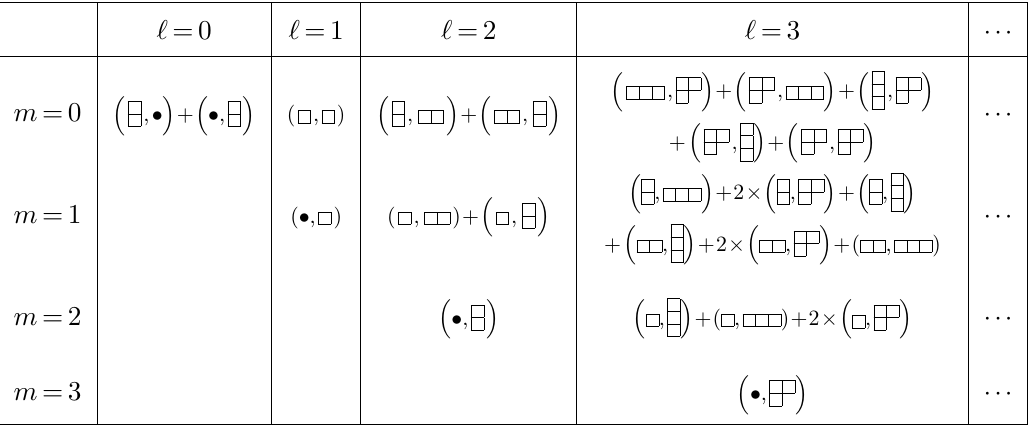
Table 5 . The free Lie algebra for the ‘magnetic’ string Galilei algebra. As objects now transform under SO( D (cid:0) p (cid:0) 1) (cid:2) SO(1 ; p ) we list the representations as pairs of Young tableaux (of the corresponding linear group). The (cid:12)rst entry in each pair refers to the transverse rotation group. The new feature compared to the point particle is now the rotation generator M